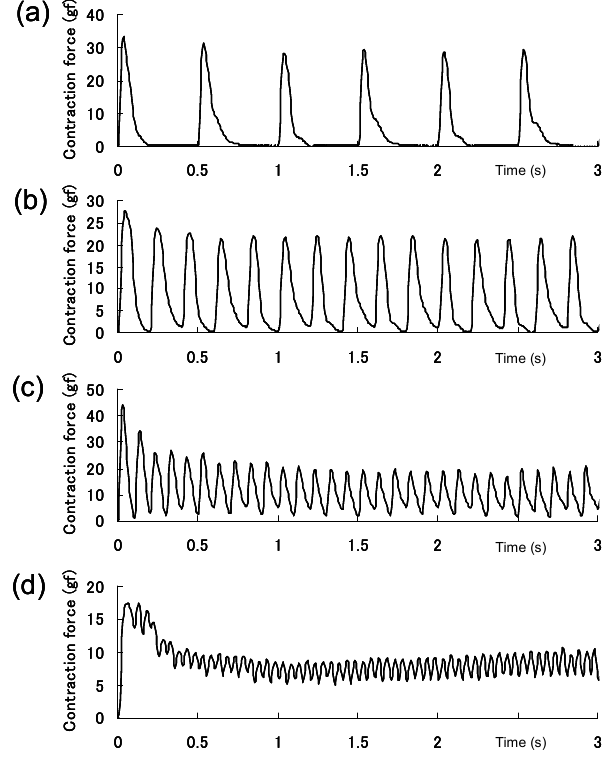
Fig. 5 Typical responses of a rat quadriceps to electrical stimulation at varied stimulation frequencies: (a) 2 Hz; (b) 5 Hz; (c) 10 Hz; and (d) 20